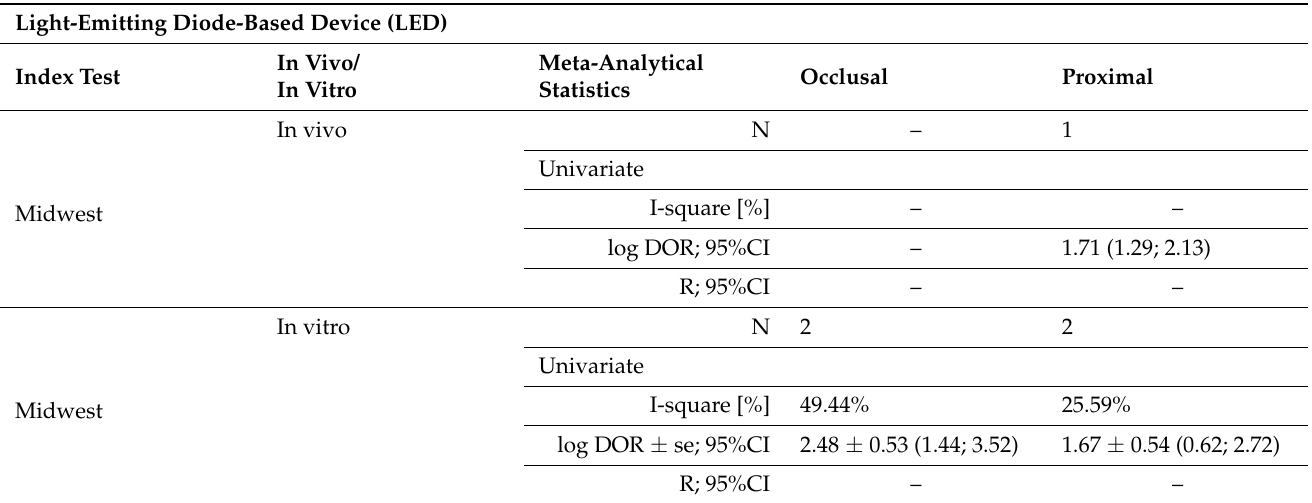
Table 7. Meta-analytical results for the Midwest test. Only univariate statistics could be determined, due to the limited number of studies in each